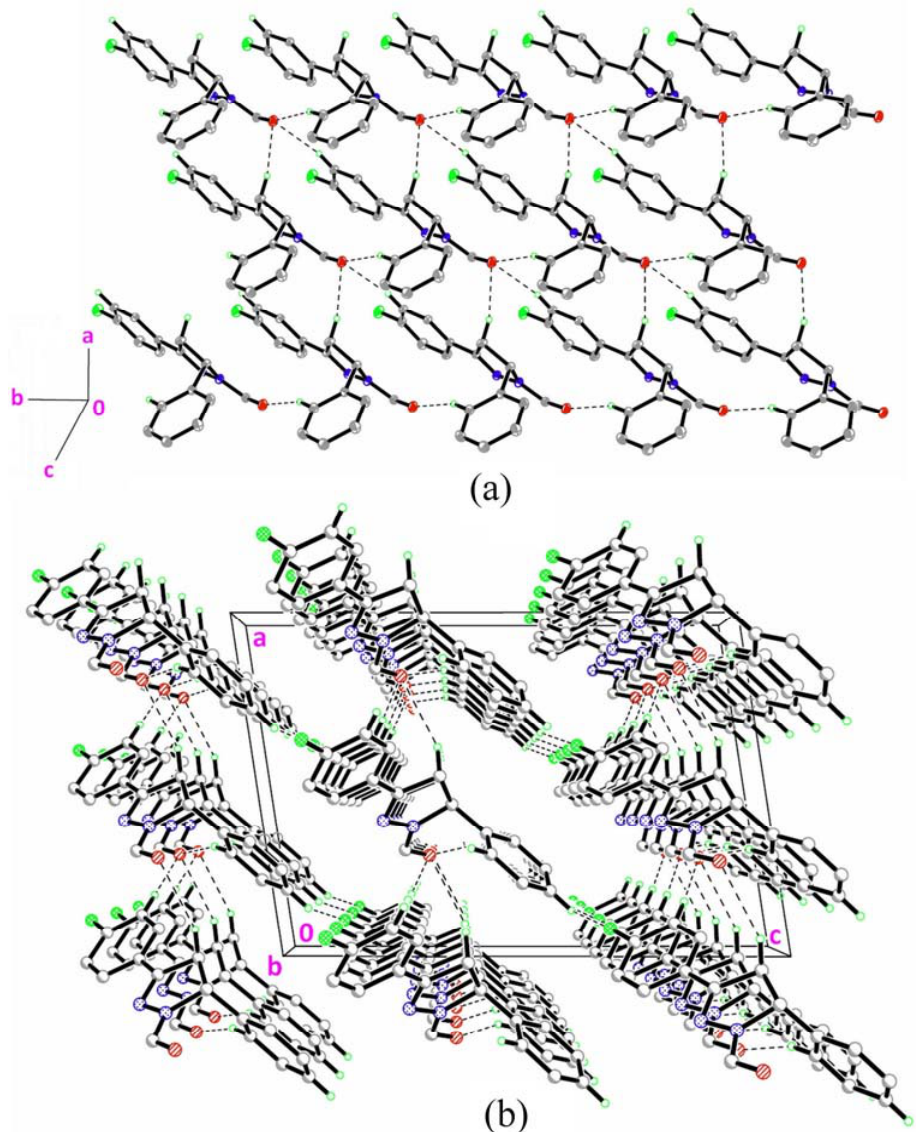
Figure 2. ( a )–( b ) Crystal structure of compound 1 with intermolecular hydrogen bonding patterns shown as dashed lines. H atoms not involved in the crystal structure have been omitted for clarity.